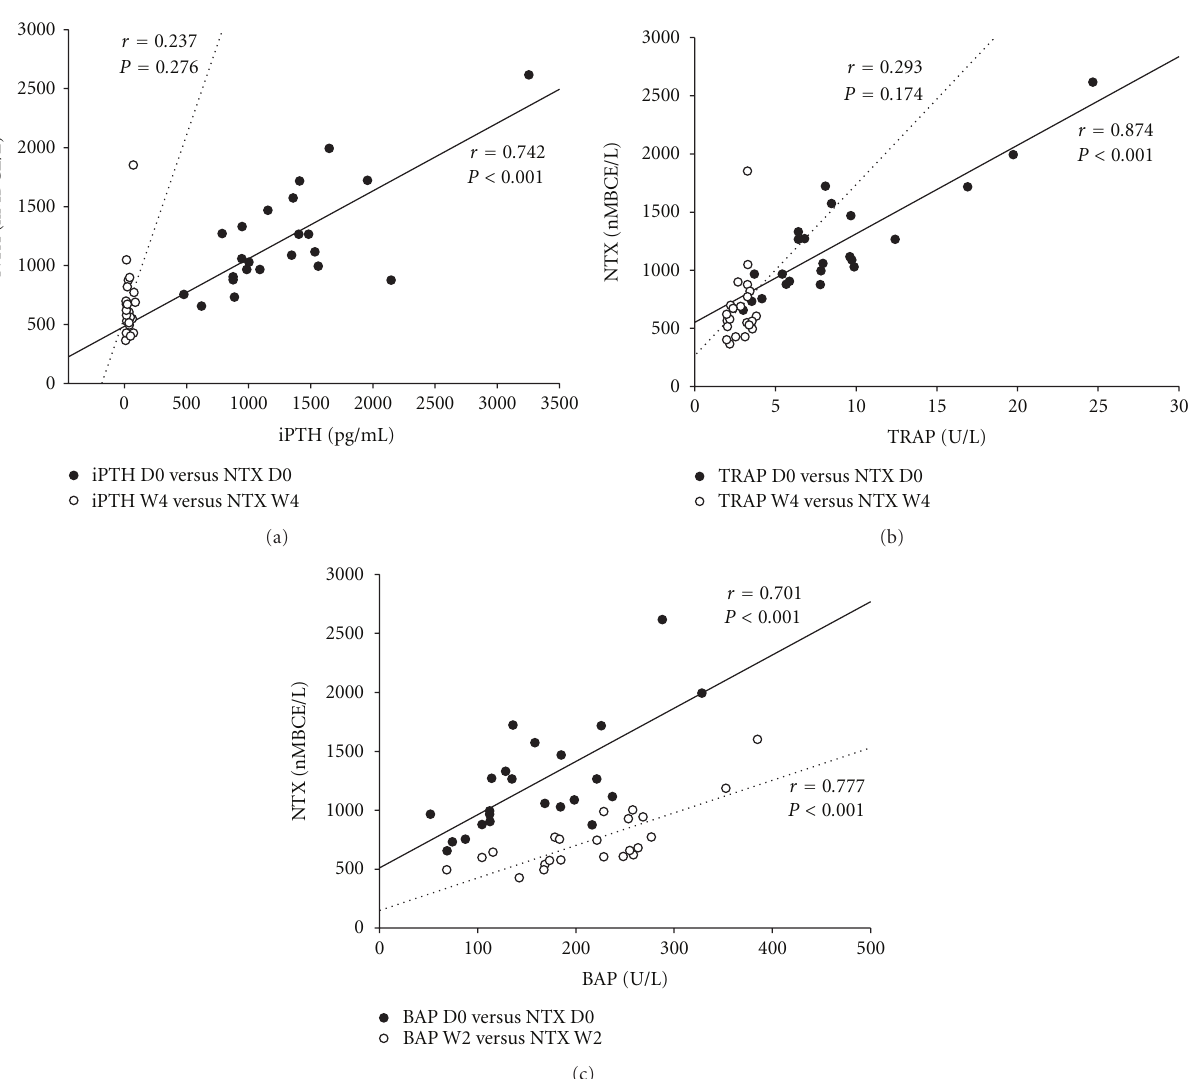
Figure 2: Correlations between serum values for the cross-linked N-telopeptide of type I collagen (NTX) and those for other bone biomarkers before and at 2 or 4 weeks following parathyroidectomy for secondary hyperparathyroidism. (a), Correlation with intact parathyroid hormone (iPTH); (b), correlation with tartrate-resistant acid phosphatase 5b (TRAP); (c), correlation with bone-specific alkaline phosphatase (BAP). D0, before surgery; W2, 2 weeks post-surgery; W4, 4 weeks post-surgery. Spearman’s correlation coe ffi cients were calculated assuming a nonnormal